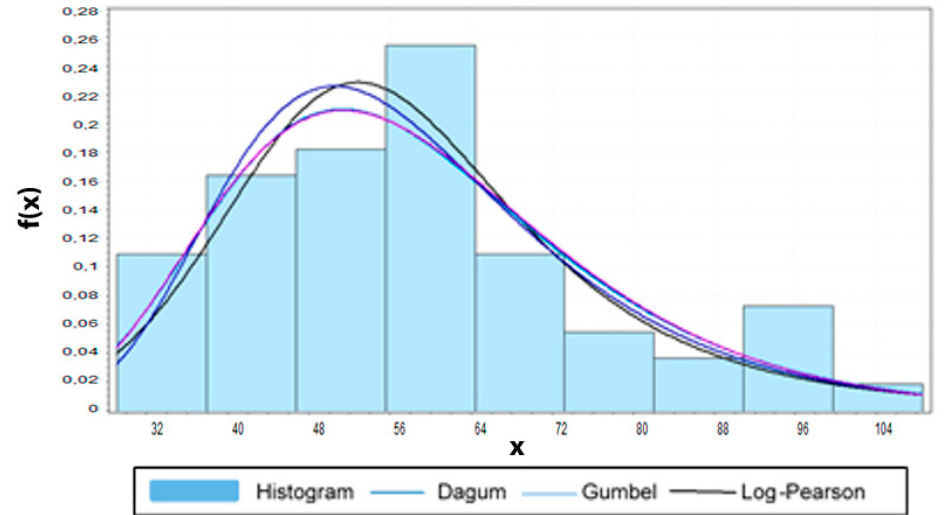
Figure 5. Probability density function of Gumbel, Log-Pearson type III and Dagum Distributions. Comparison of the fit among the three different distributions applied to the histogram of the data from San Vicente de Alcántara.